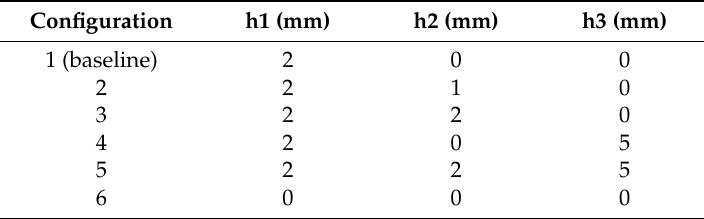
Table 1. Geometric parameters for each analyzed configuration.